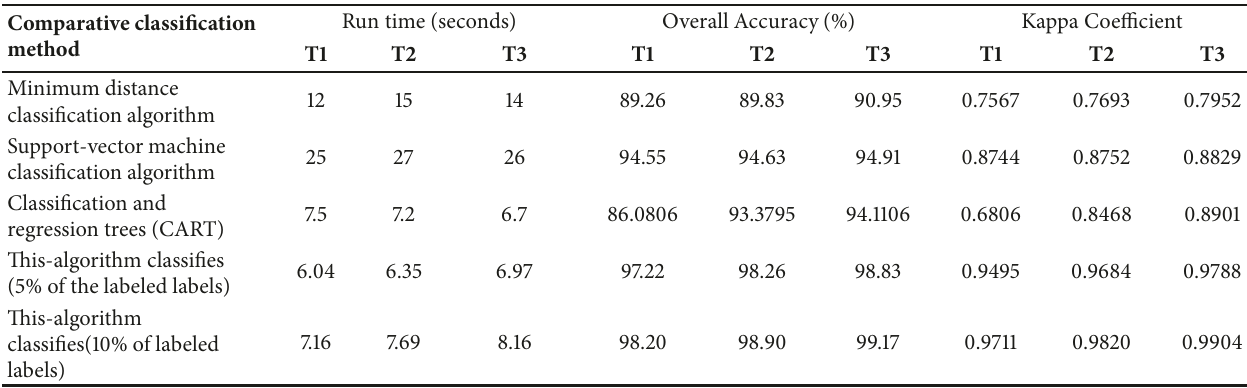
Table 4: The comparison of overall accuracy and Kappa coefficient under different classifier algorithm of Hyperion